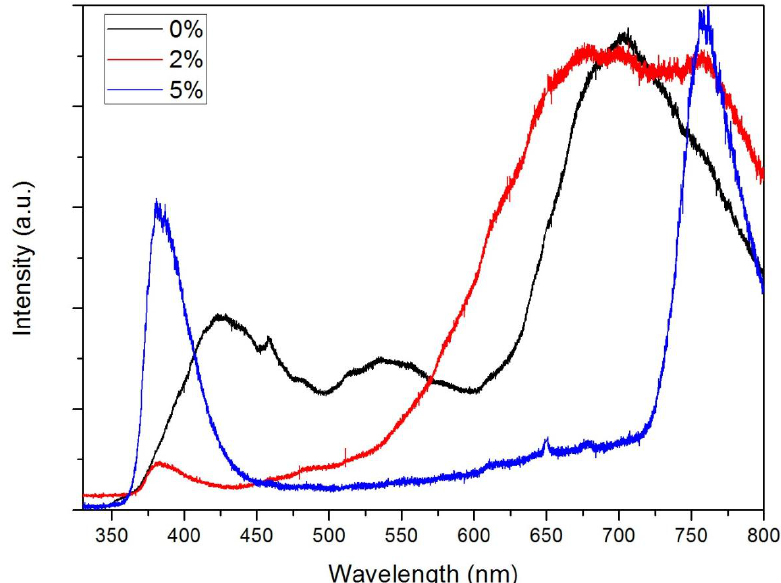
Figure 5. Photoluminescence spectra of Cu x Zn 1− x O ( x = 0, 0.02,